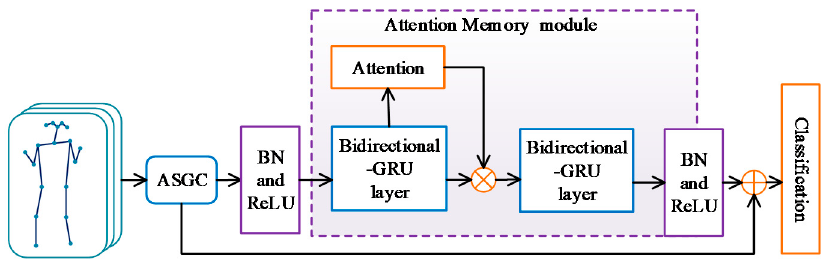
Figure 3. The overall architecture of the proposed Adaptive Attention Memory Graph Convolutional Networks.